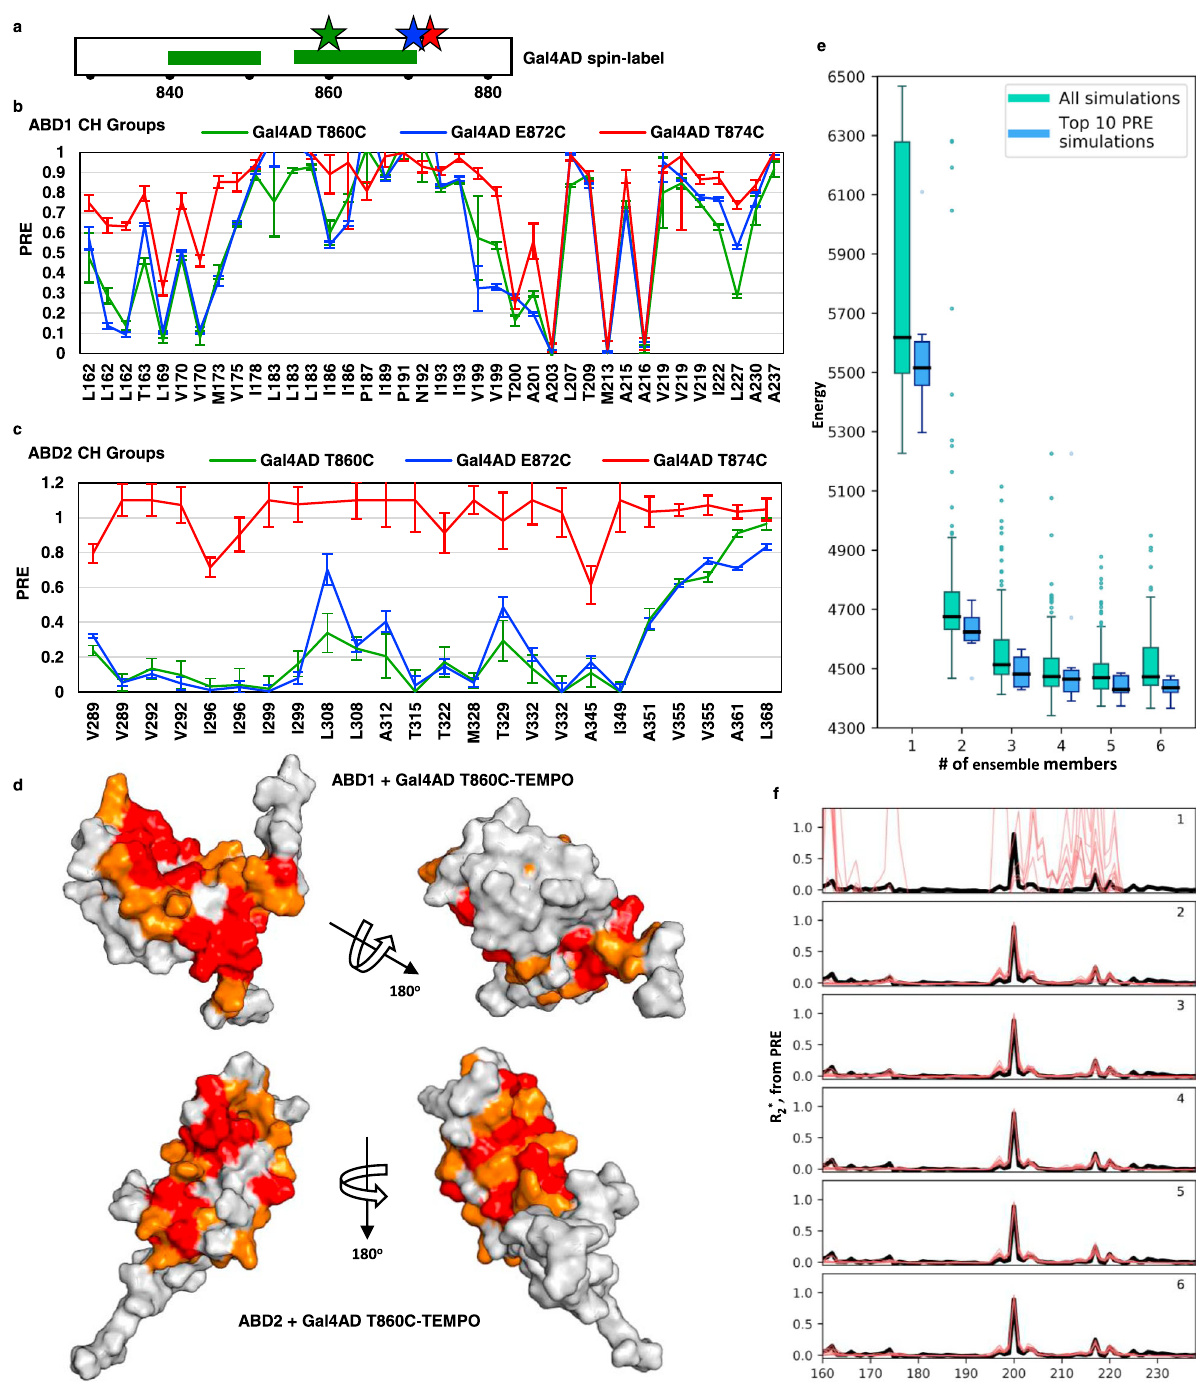
Fig. 5 Paramagnetic relaxation effects (PRE) on ABD1 and ABD2 when bound to spin-labeled Gal4 AD. a TEMPO spin-label was attached at Gal4 AD positions T860C, E872C, or T874C. PRE of each spin-labeled AD is shown for CH groups for b ABD1 and c ABD2 (see Supplementary Fig. 4 for NH group data). Error bars represent standard error-based spectral noise intensities. d Results of the ABD + Gal4 AD T860C-TEMPO experiments are plotted on the structures of ABD1 (pdb 2LPB) and ABD2 (pdb 6ALY). The top 25% affected residues are red, the next 25% are orange. A similar PRE pattern of effect is measured when the spin-label is attached at either side of the primary interacting region of Gal4 AD. e , f Simulations of the Gcn4 cAD:ABD1 complex using previous data (Brzovic et al. 33 , Tuttle et al. 32 ) demonstrate that multiple ensemble members are required to satisfy the PRE data. e The total energy for all structures (green) and the ten lowest PRE energy term structures decreases signi fi cantly when structures have multiple ensemble members. Box plots re fl ect the 25th to 75th percentile, a dark midline denotes the median, whiskers extend to a maximum of 1.5× IQR beyond the box. f The PRE, calculated as a pseudo relaxation rate R 2 * for structure calculations, requires multiple ensemble members to recapitulate the experimental data. Inset number indicates the number of states in each structure: 1 at top to 6 at bottom. See also Supplementary Fig.